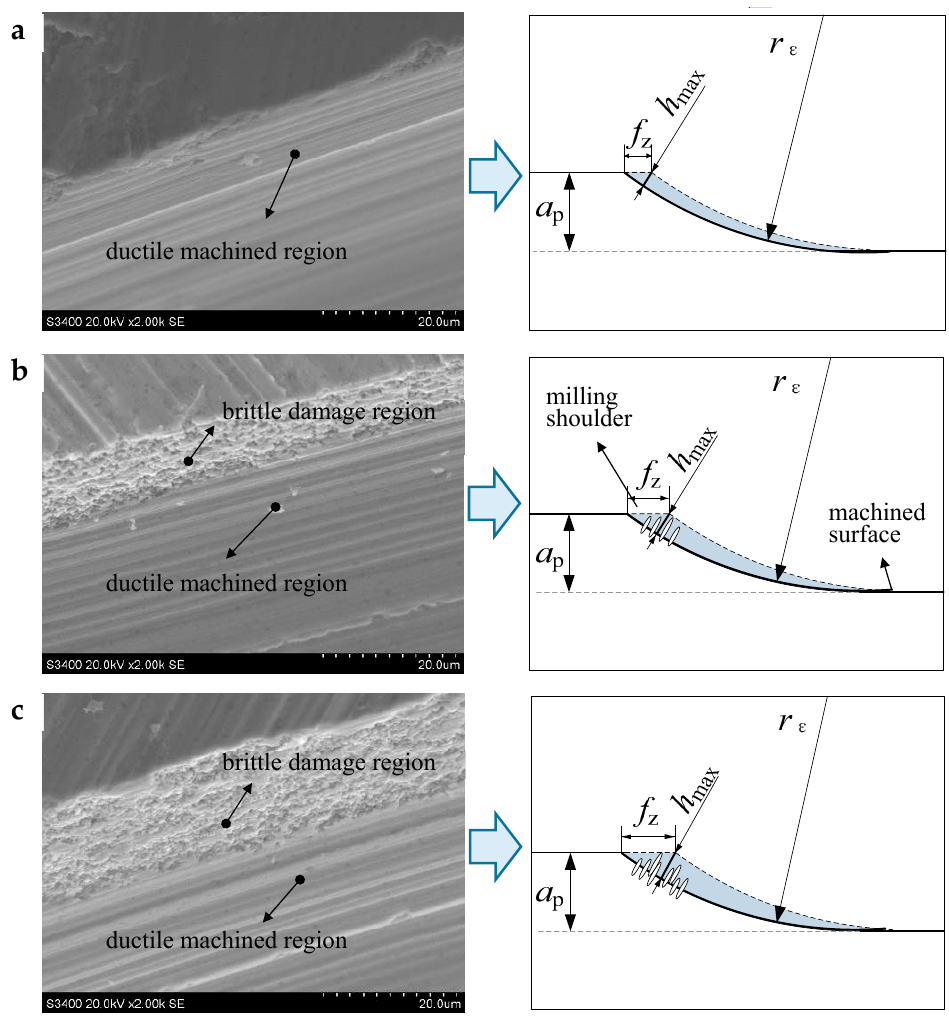
Figure 8. Characteristics of machined surface under different h max , ( a ) f z = 3 μ m, a p = 20 μ m, h max = 1.8